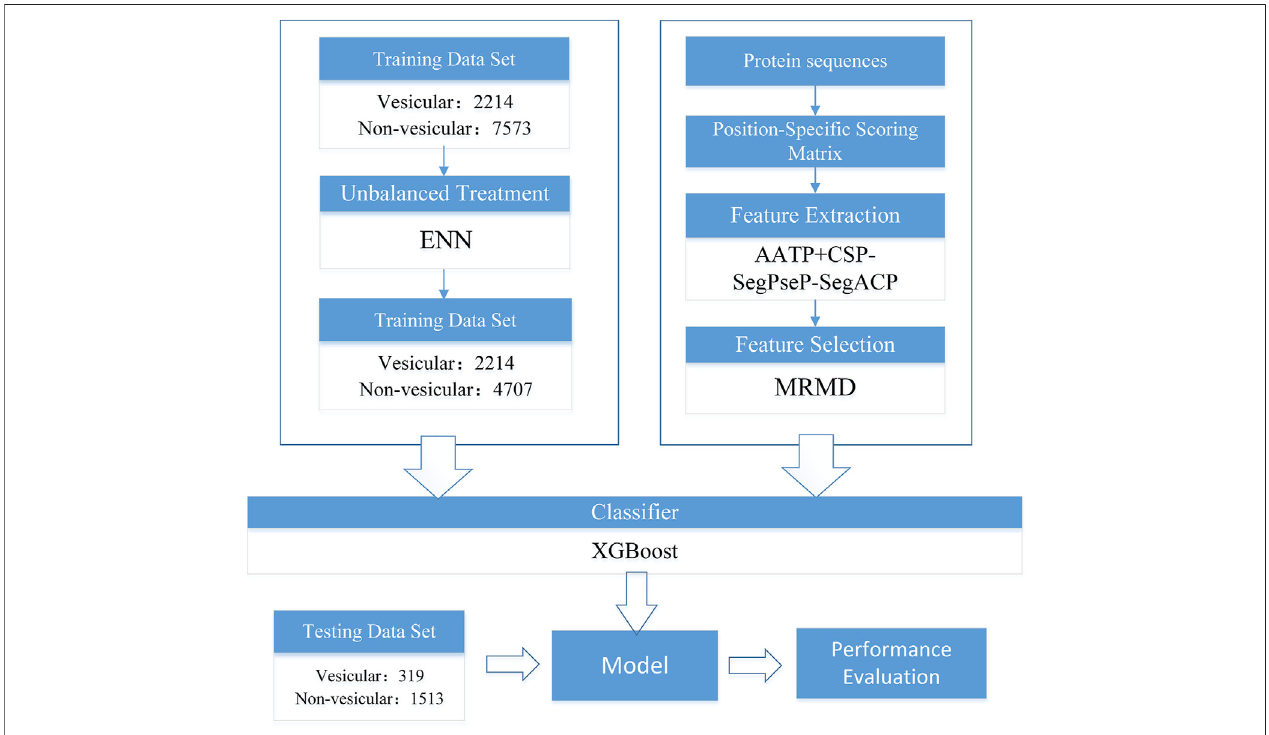
FIGURE 1 | Training fl ow chart of the prediction model of vesicular transport